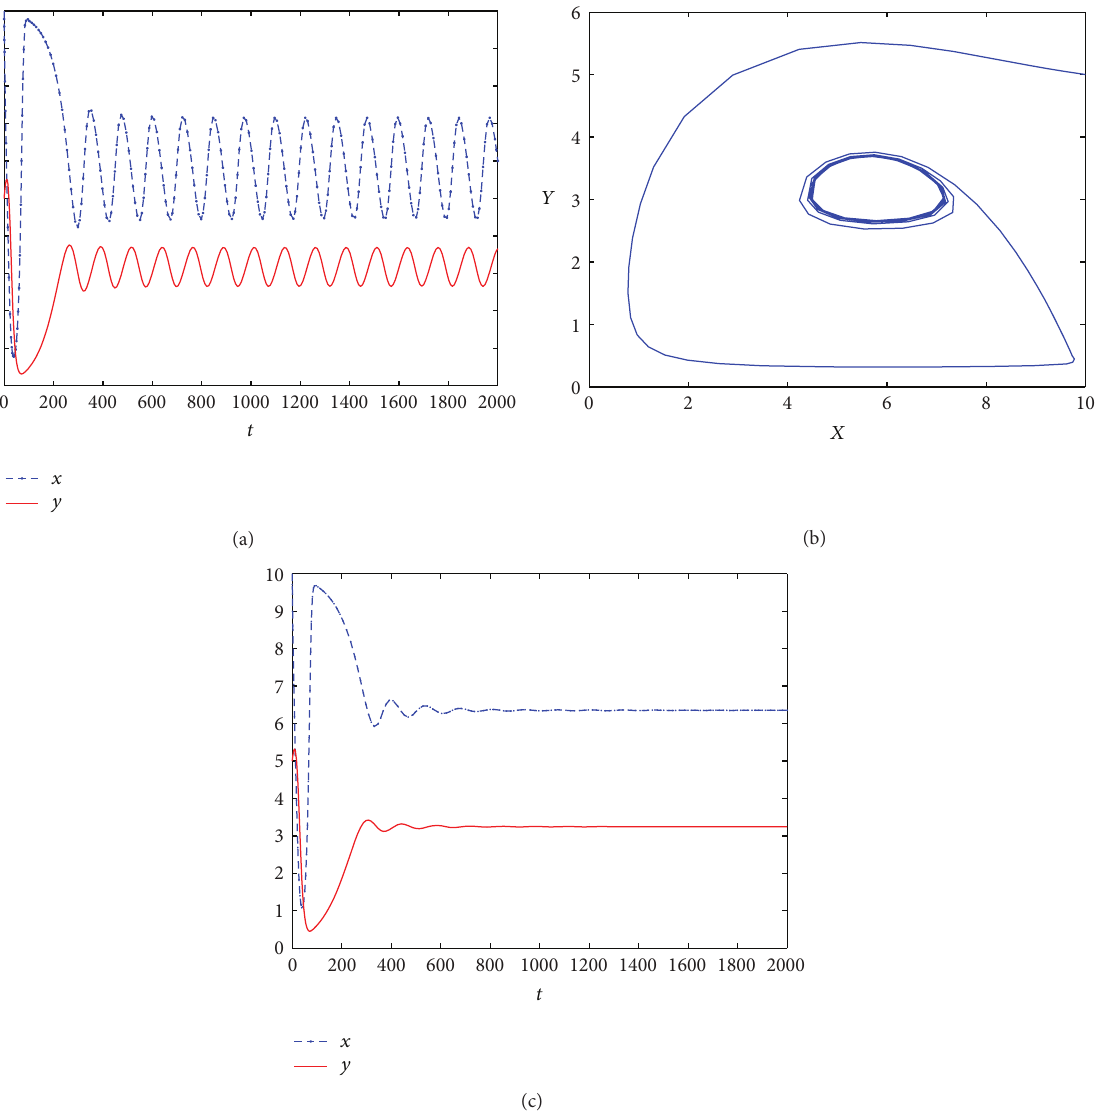
Figure 4: The infected steady state 𝐸 ∗ of system (2) is unstable when 𝜏 = 0.55 (a) (b) and stable when 𝜏 = 0.75 (c). The rest parameter values are given in (i), and the initial values are 𝑥 0 = 8 and 𝑦 0 = 5